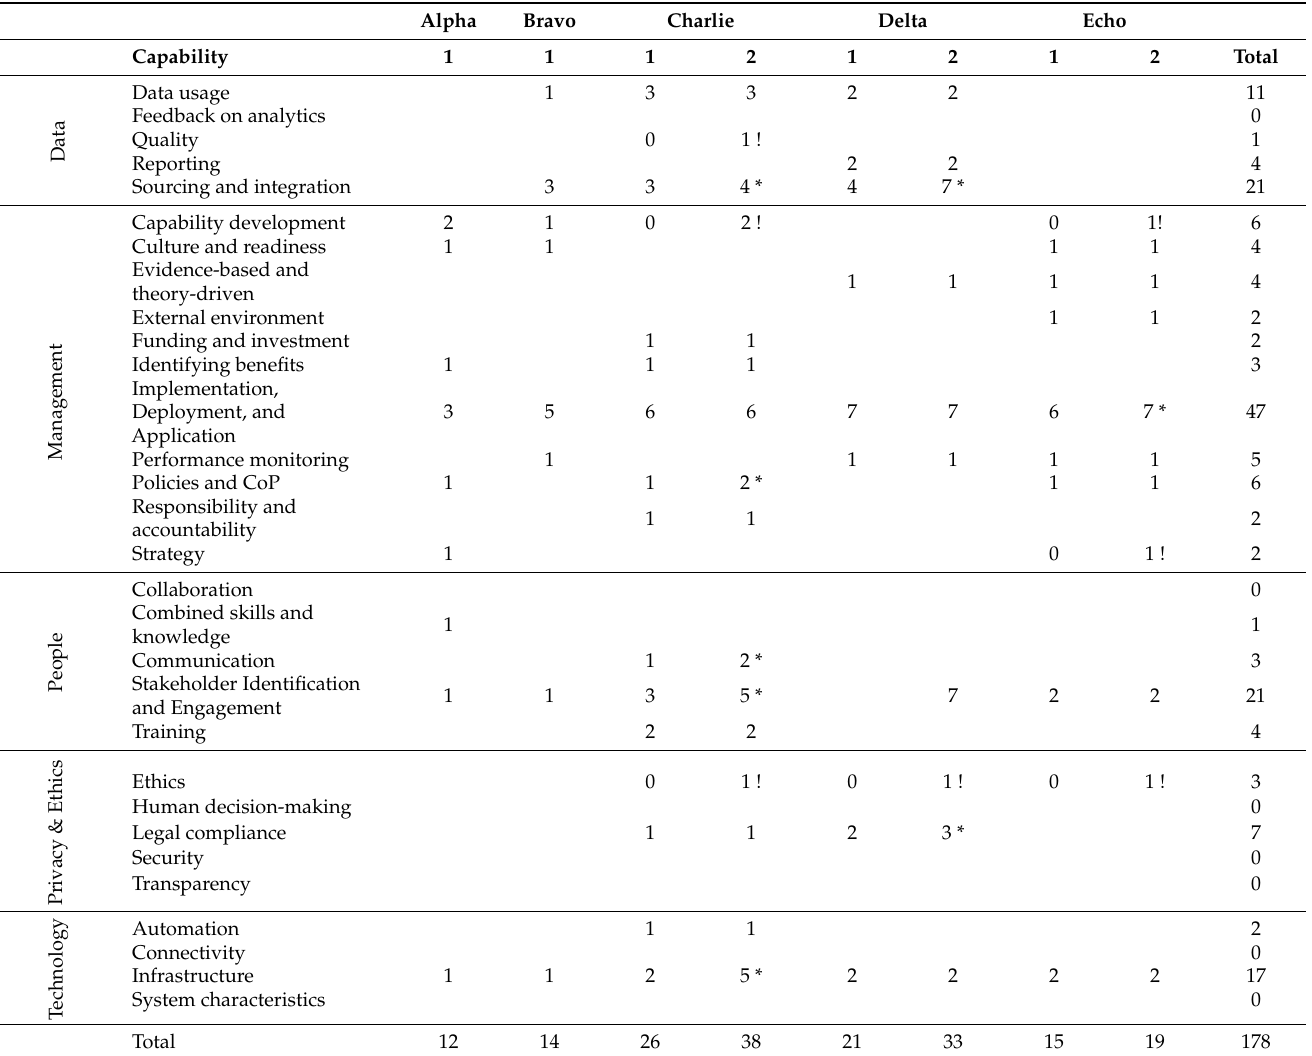
Table 3. Codes assigned to the first roadmaps (1) and the second, enhanced roadmaps (2). Numbers with an asterisk (*) indicate an increase in capabilities. Numbers with an exclamation mark (!) indicate the uptake of new